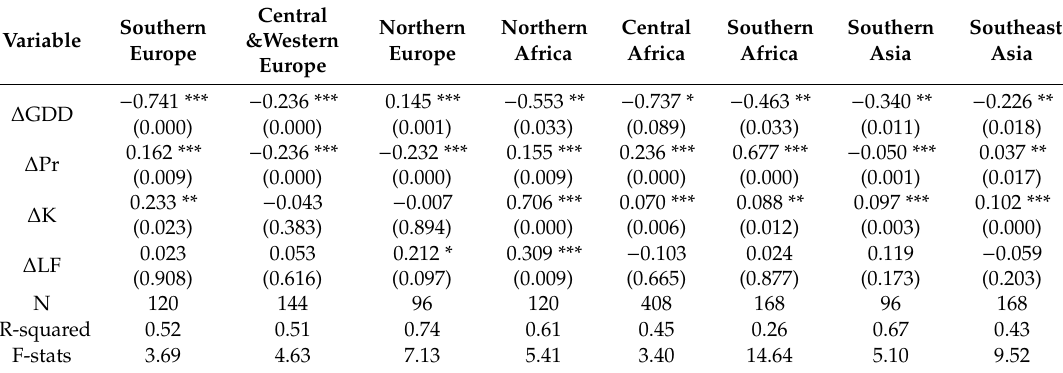
Table 1. Impacts of climate change on cereal